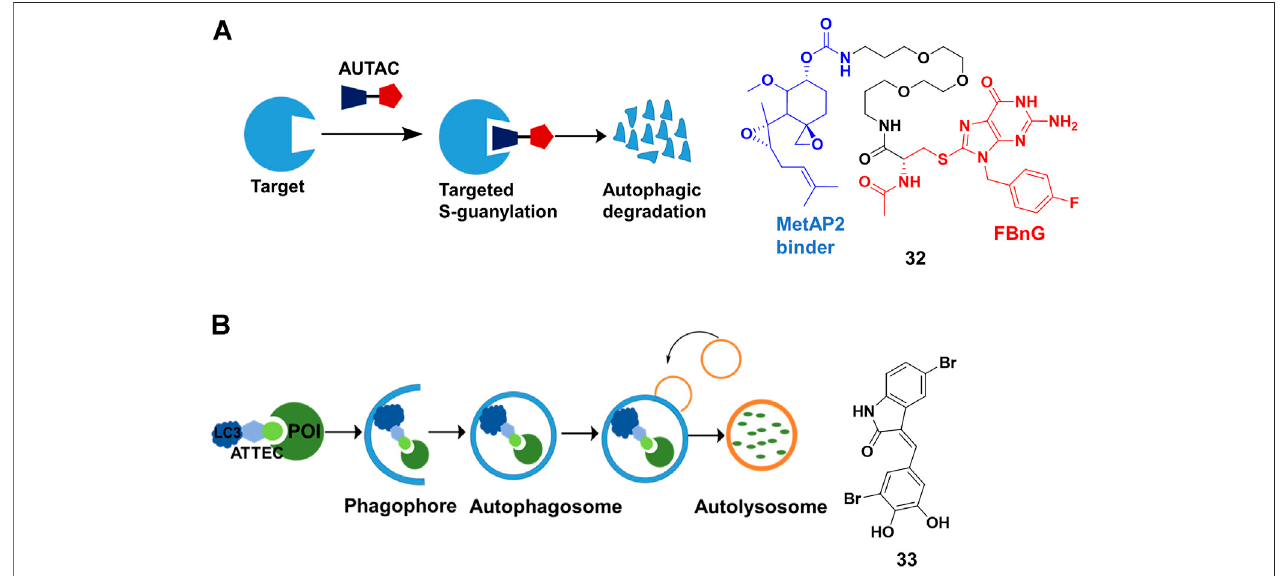
FIGURE 11 | (A) Action mode and chemical structure of autophagy-targeting chimeras (AUTACs). (B) Action mode and chemical structure of autophagosome- tethering compound (ATTEC).